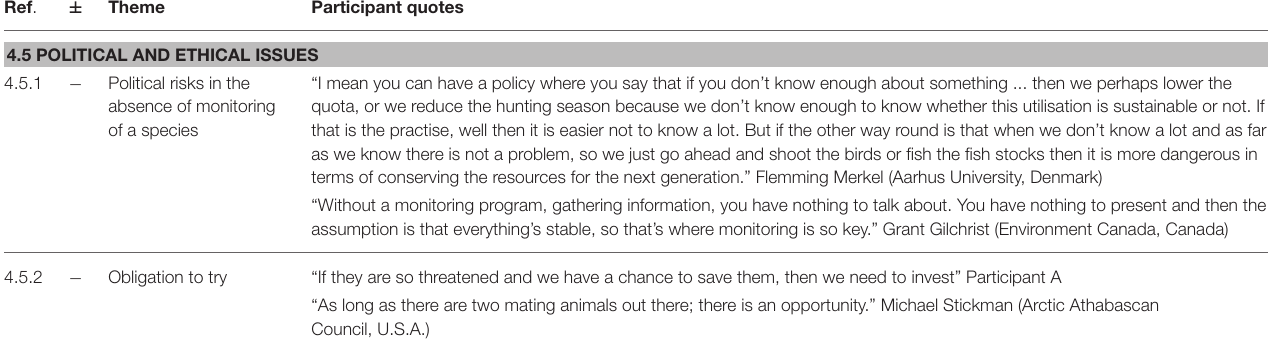
TABLE 4 | Summary of perspectives on political and ethical issues and factors that modify the applicability of triage in arctic wildlife monitoring. Ref